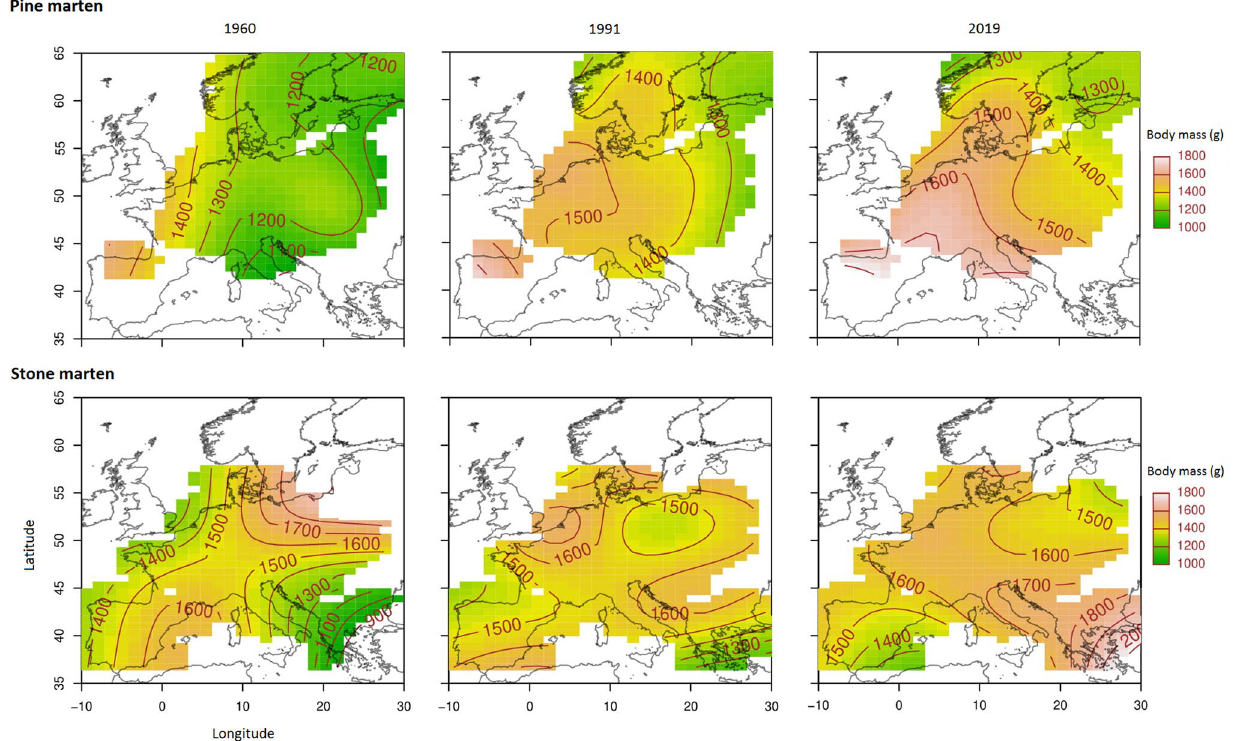
Figure 1. Spatial gradients in body mass of pine and stone marten males in Europe based on results of GAMs. Maps were produced for 3 years with approximately 30-year intervals (1960, 1991, and 2019). Interpolated lighter oranges and reds indicate greater body mass in grams; darker greens indicate lower body